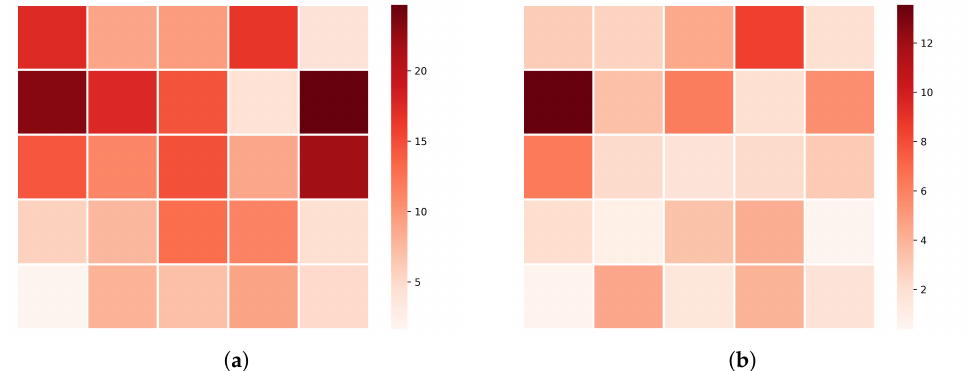
Figure 3. Spatial distribution of downlink traffic at different times. ( a ) 8:00 a.m.; ( b ) 10:00 p.m. (the square represents a BS, and the color of a square represents the volume of BS-level downlink